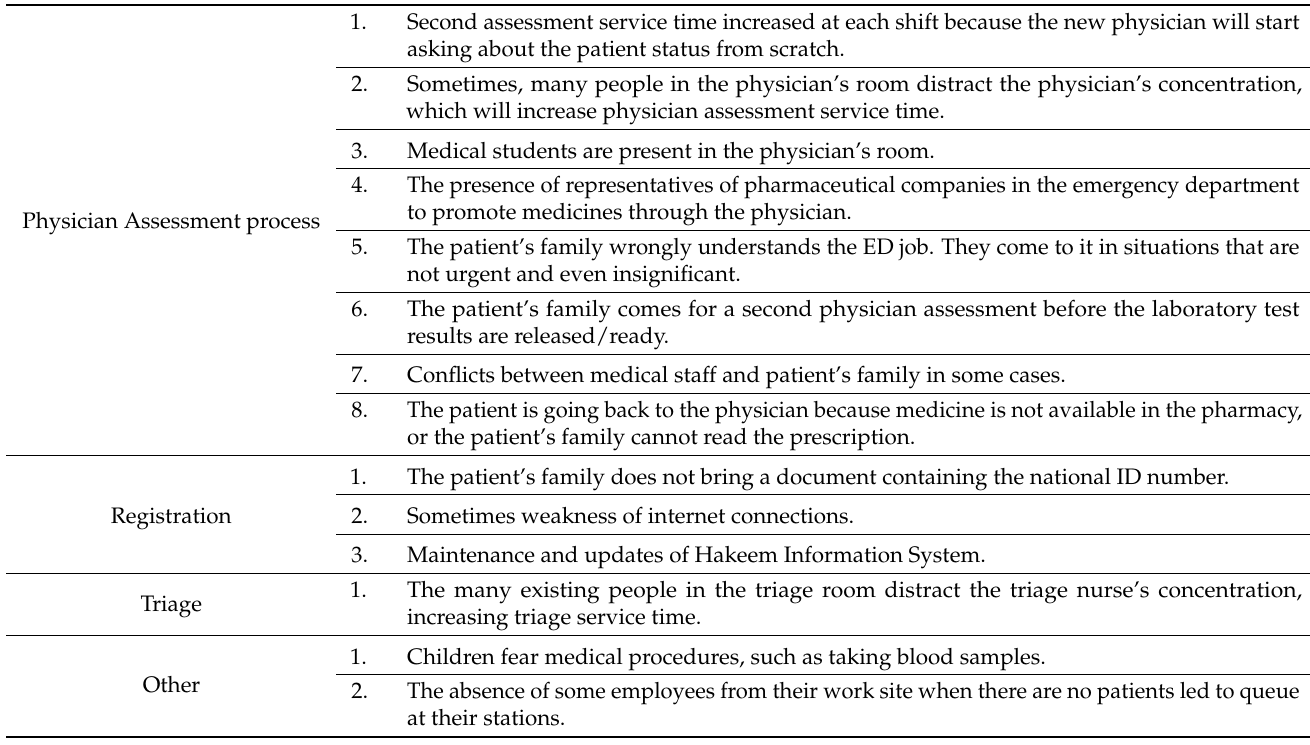
Table 10. Causes of variability in the service and waiting times of each